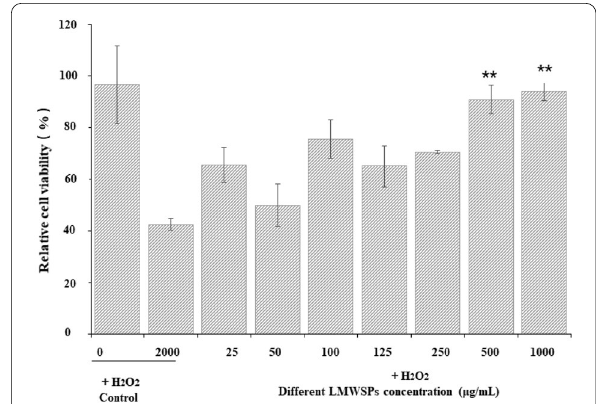
Fig. 3 Protective effects of LMWSPs against H 2 O 2 -induced oxidative stress on the L02 cells. Data are expressed as mean ** P < 0.01 (compared with H 2 O 2 control